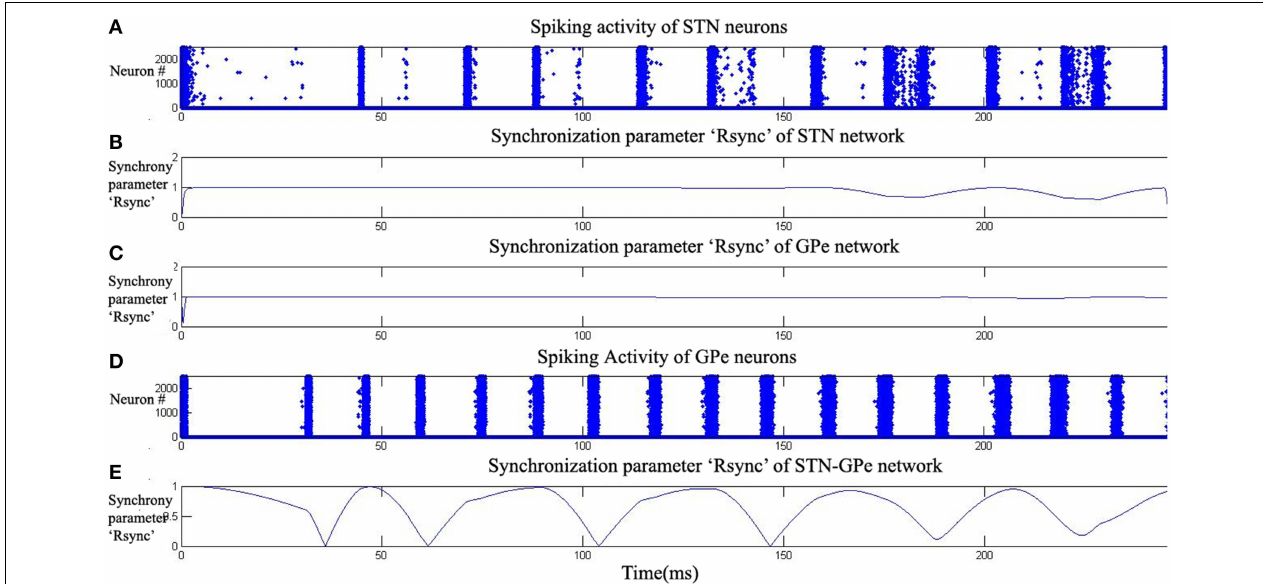
FIGURE 5 | Highly synchronized activity of STN-GPe system at low dopamine level (DA = 0.1). Plots (A,D) raster plots indicate the activity of STN and GPe neurons with time. Plots (B,C,E) indicate the synchronization parameter ( R sync ) calculated for STN, GPe and STN-GPe respectively.